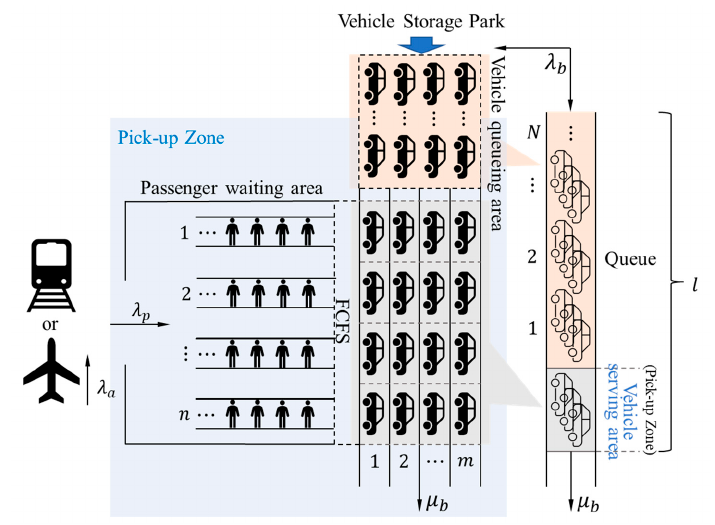
Figure 3. Queueing representation of traffic flows.